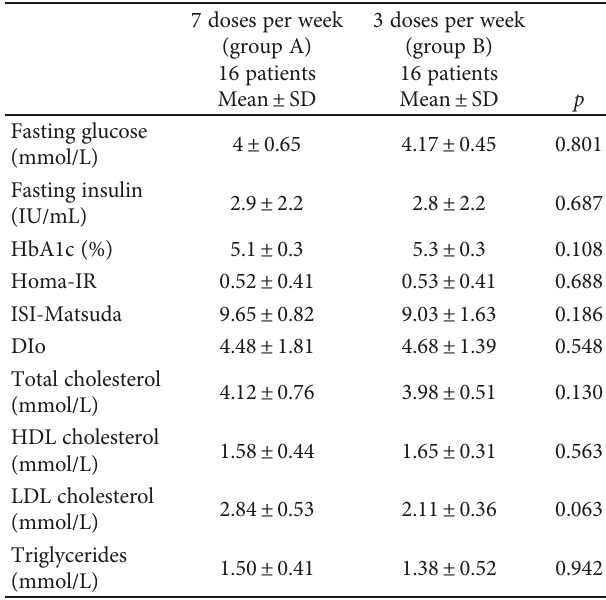
Table 2: Di ff erence in metabolic parameters between patients grouped according to the GH treatment regimen (group A and group B) at